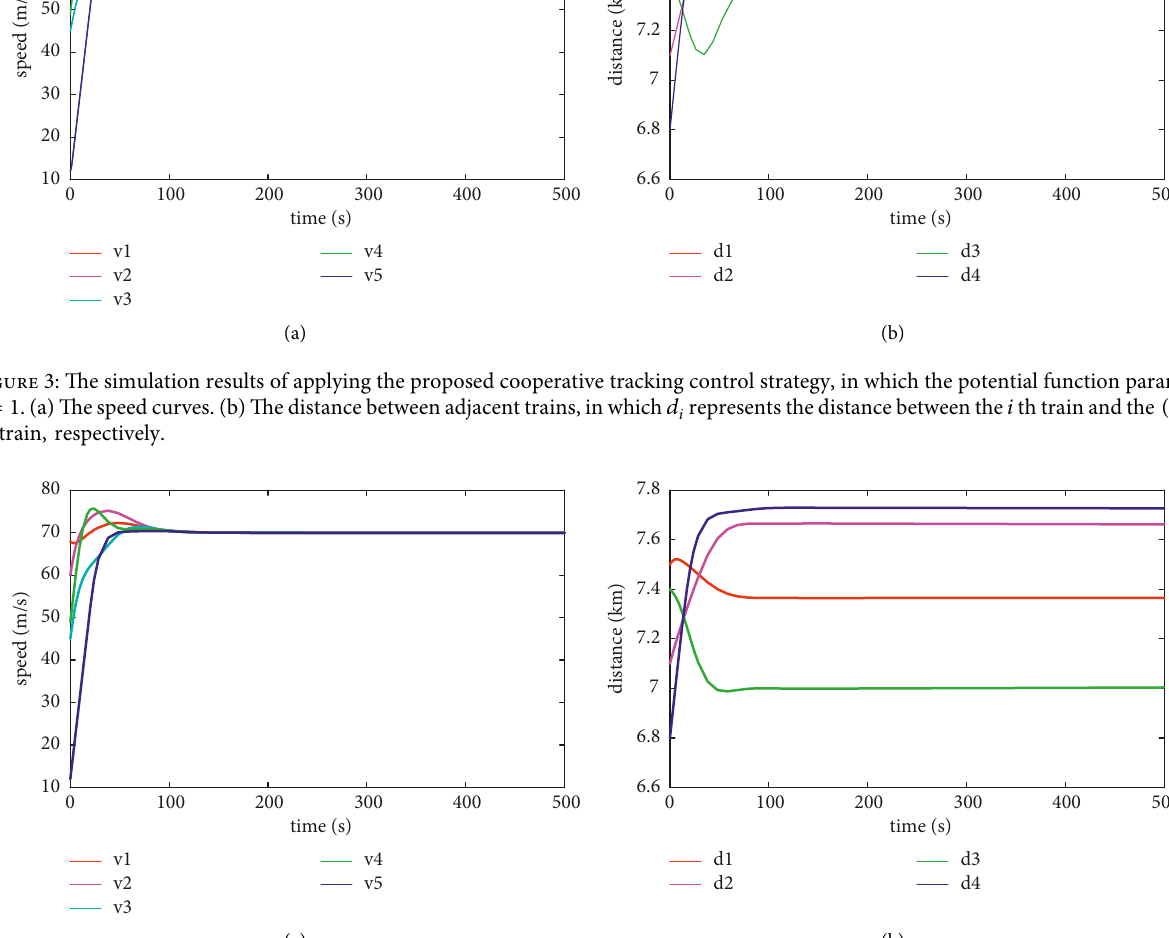
Figure 4: The simulation results of applying the proposed cooperative tracking control strategy, in which the potential function parameter a � 5. (a) The speed curves. (b) The distance between adjacent trains.